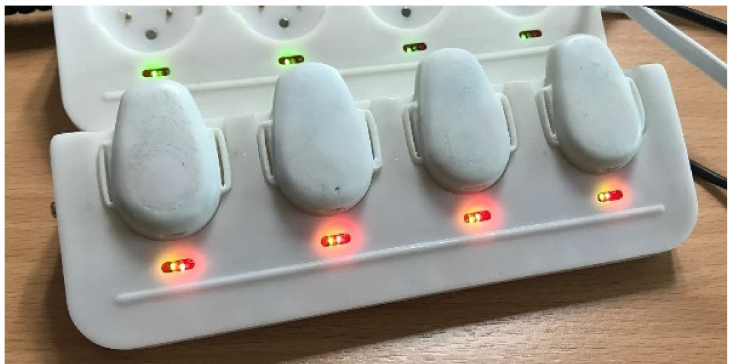
Figure 7. AiR node for monitoring activity and behavior parameters of